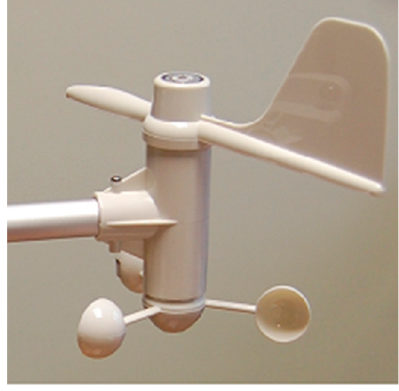
Figure 2. Cup anemometer used in the present study.